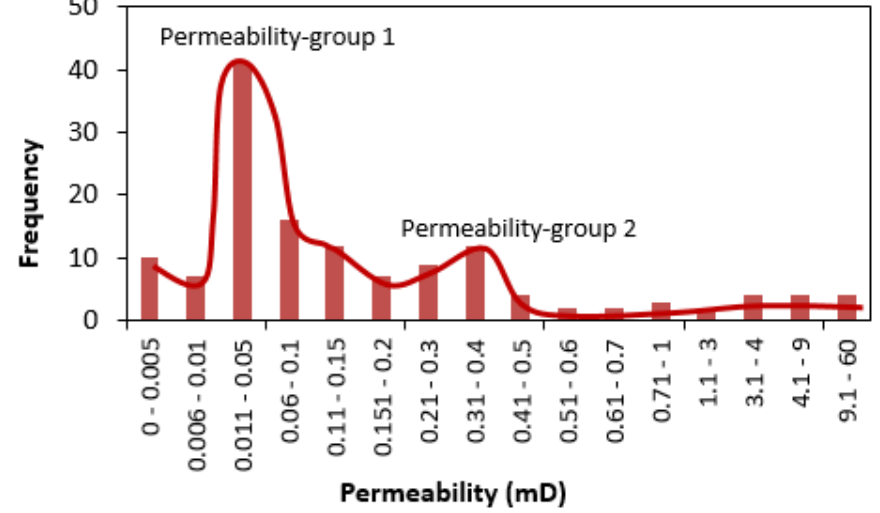
Figure 4. Permeability distribution of 140 rock samples extracted from six wells.